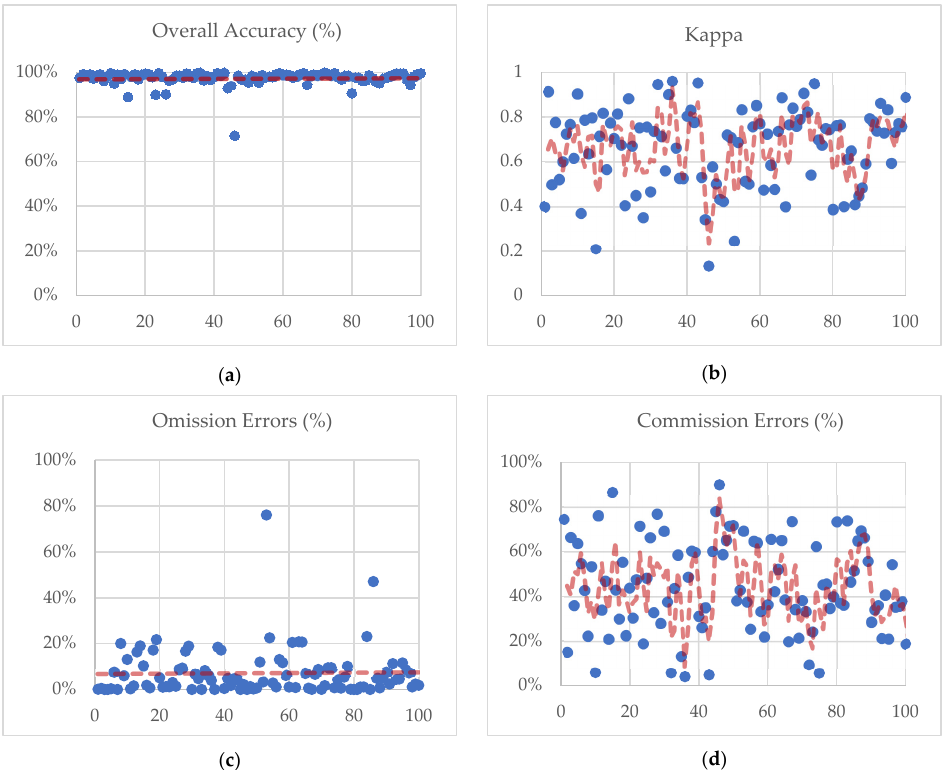
Figure 14. Performance of dam segmentation. The blue dots indicate the evaluation results of 100 test images, and the dark red dotted lines represent the trend lines for ( a ) overall accuracy, ( b ) Kappa, ( c ) omission errors, and ( d ) commission errors.